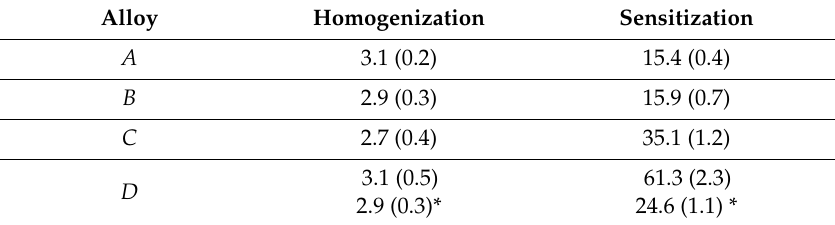
Table 4. ASTM G67 test of experimental alloys in homogenized and sensitized conditions (mg cm − 2